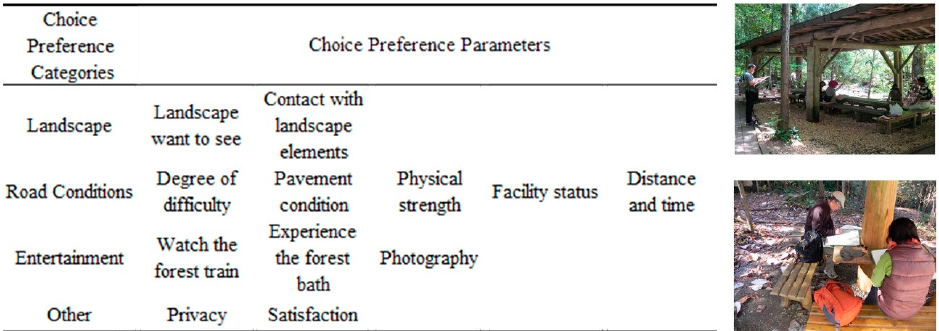
Figure 1. Akasawa National Recreational Forest.